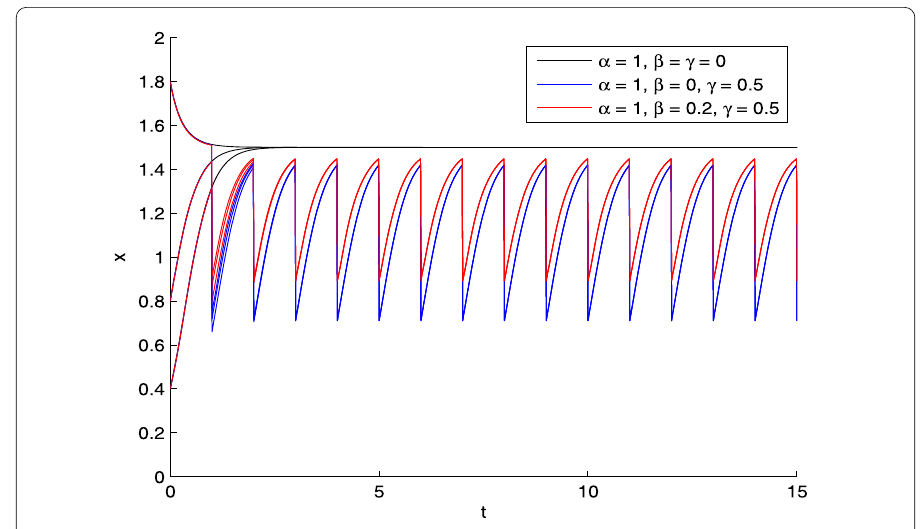
Figure 1 Dynamic behaviors of the species x ( t ) in system (1.4) with the initial conditions x (0) = 0.4, x (0) = 0.8, x (0) = 1.8, respectively